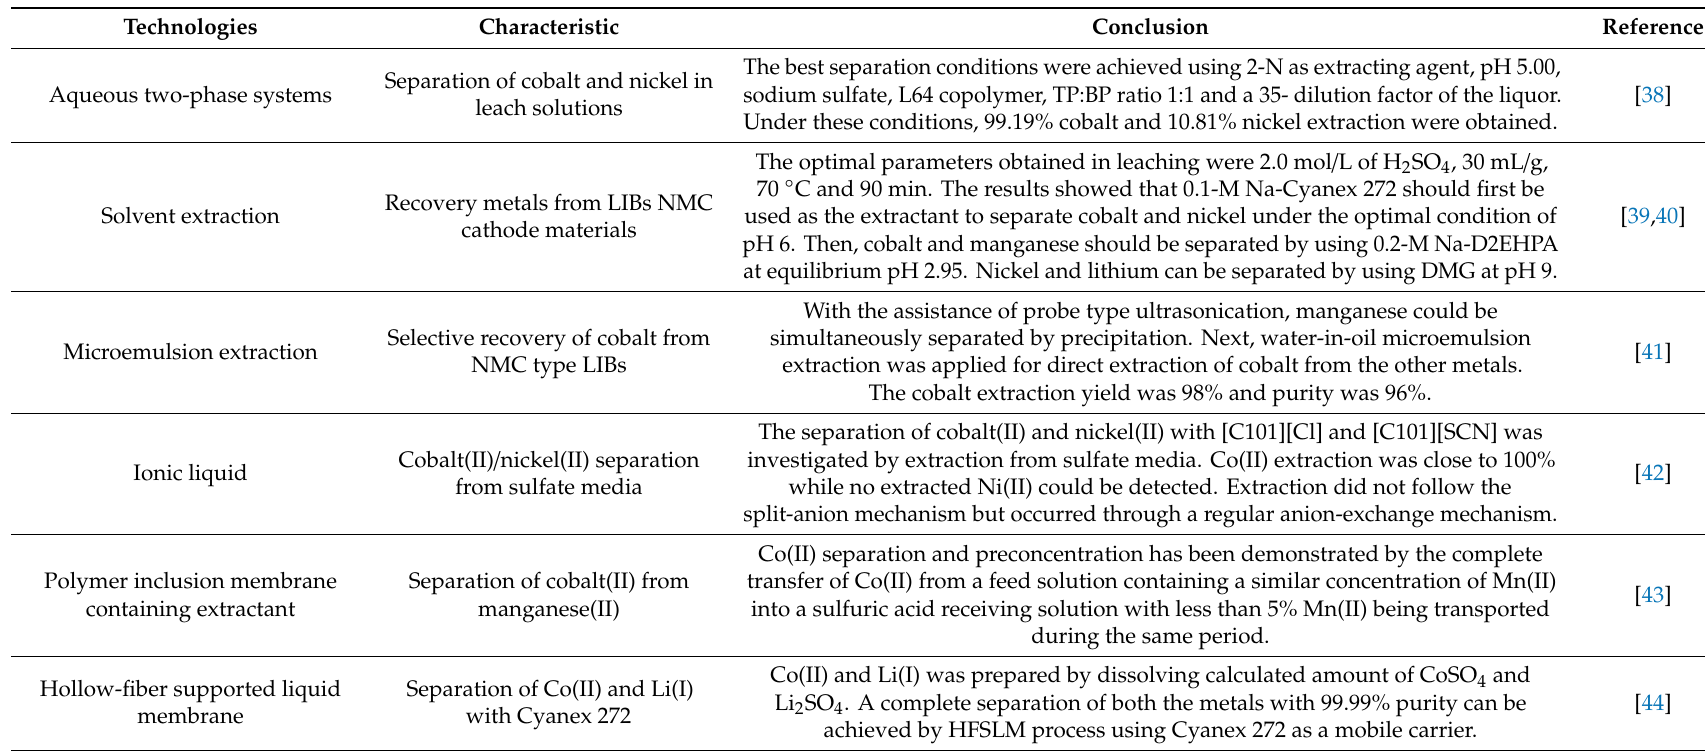
Table 3. Recent research for recovering and separation of cathodic metals from spent lithium-ion batteries